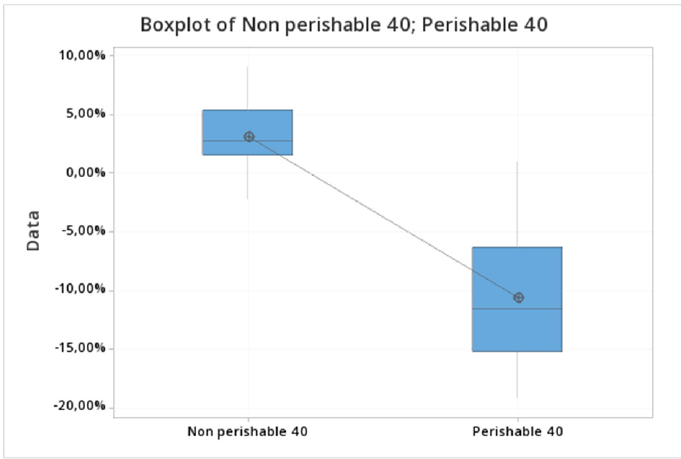
Figure 16. Boxplot CAARs event window E ( − 40,+40).